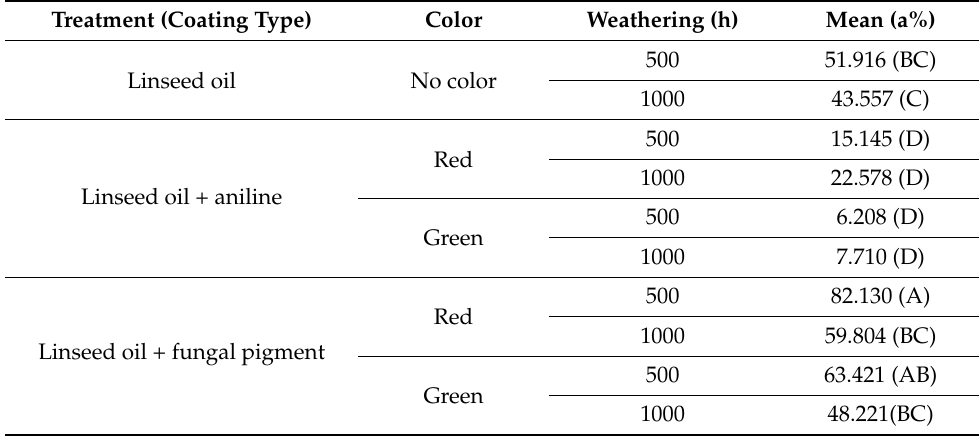
Table 2. Results for color coverage after weathering 500 h and 1000 h ( p < 0.0001). The